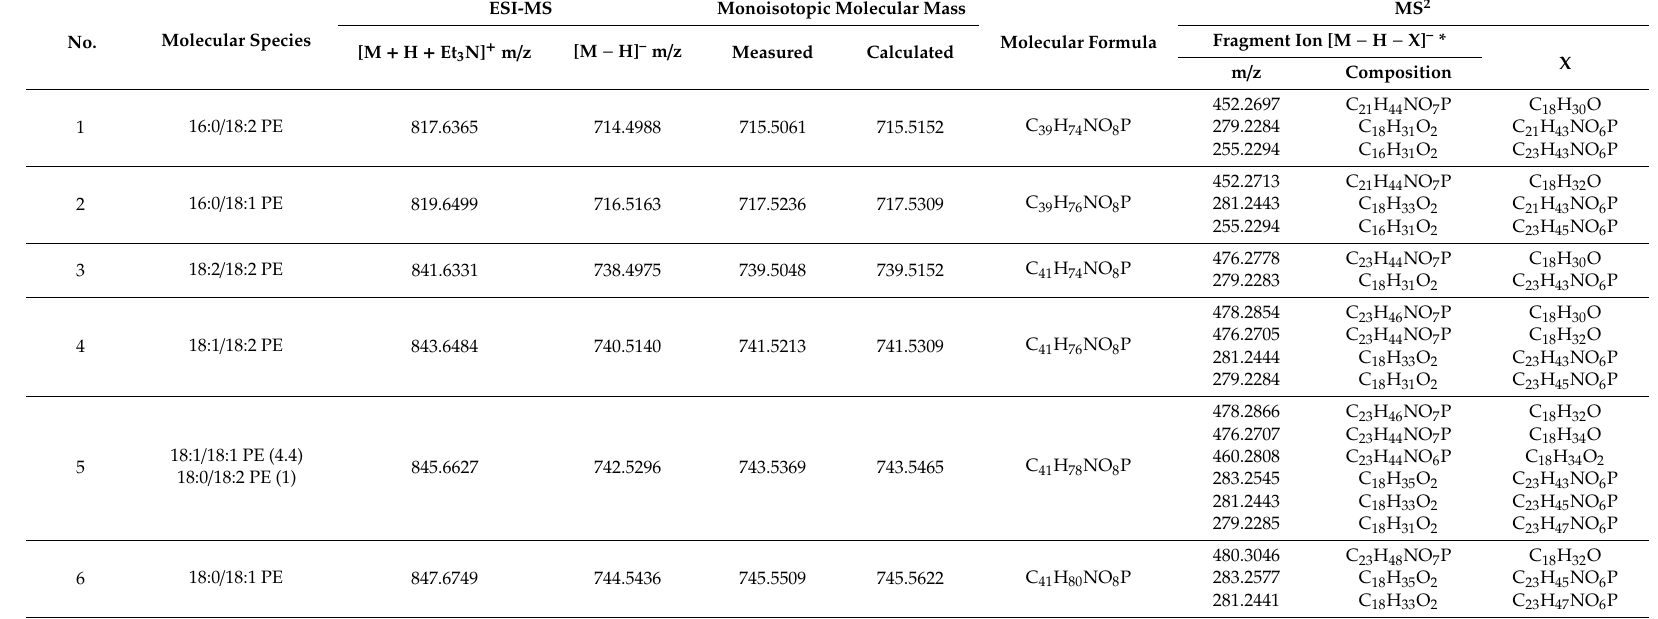
Table 3. Molecular species of phosphatidylethanolamine (PE) from Madhuca ellitica